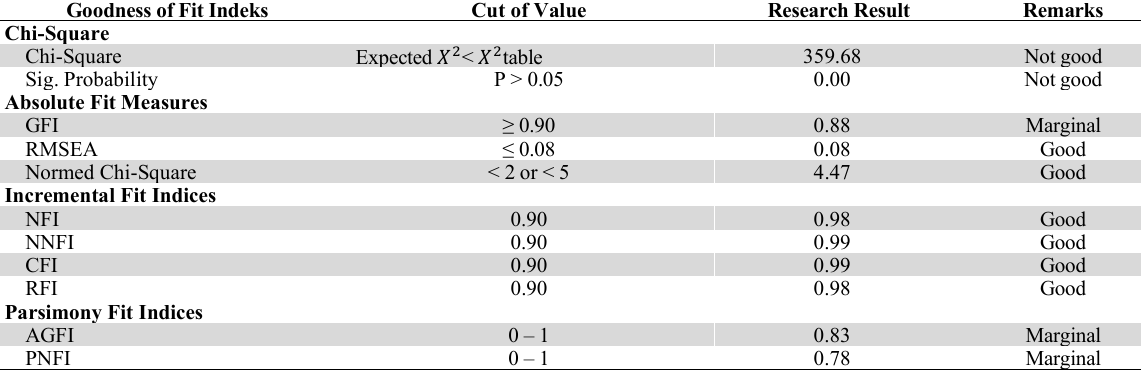
Index of Goodness of Fit Statistics